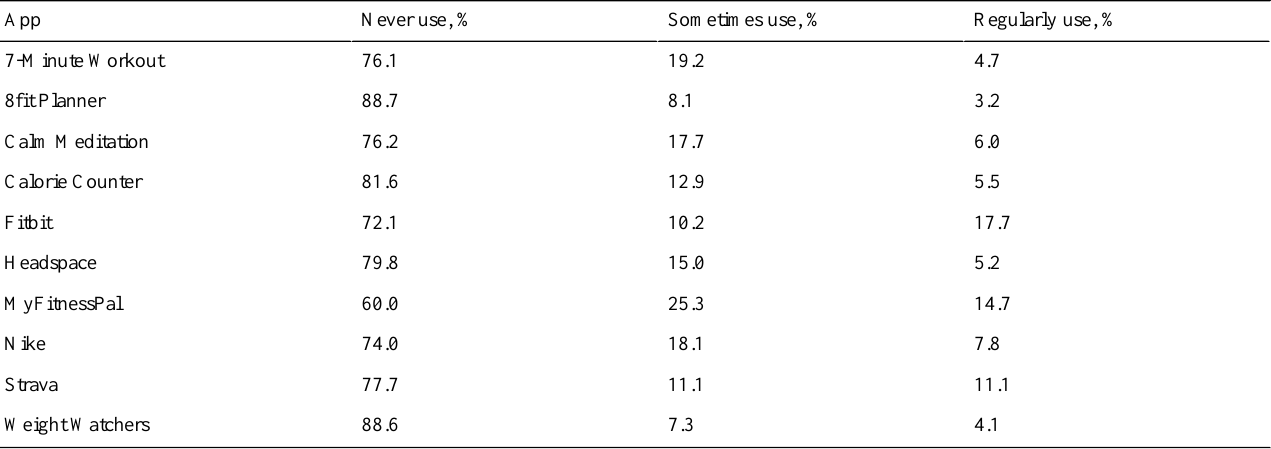
Table 4. Frequency of usage of other fitness- and well-being–related apps (N=728).